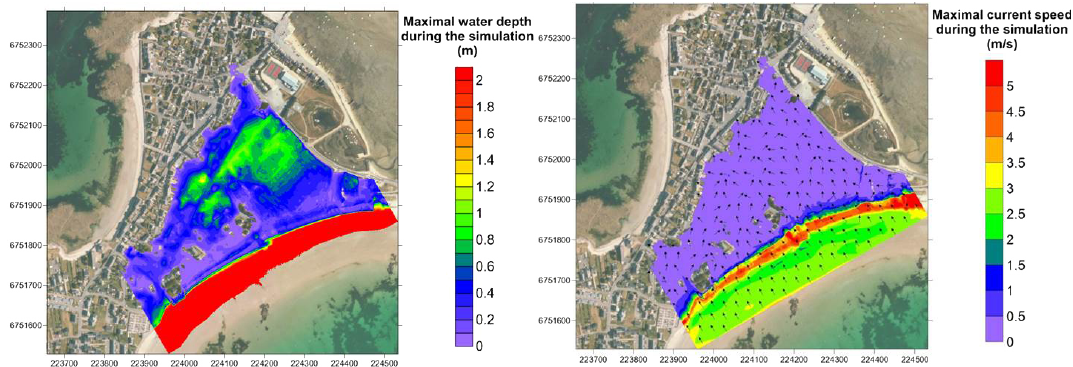
Figure 12. Maximum water depths (left) and currents (right) obtained inland during the SURF-WB simulation on the DTM (without explicit representation of the buildings).